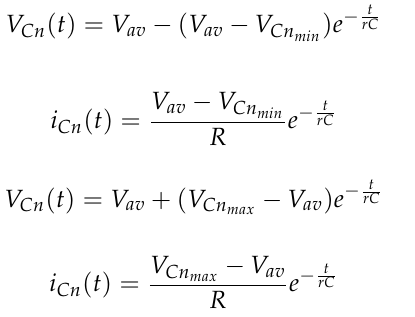
Figure 4. Operating modes of the SC converter: ( a ) first stage, T 1 ; ( b ) second stage, T 2 .